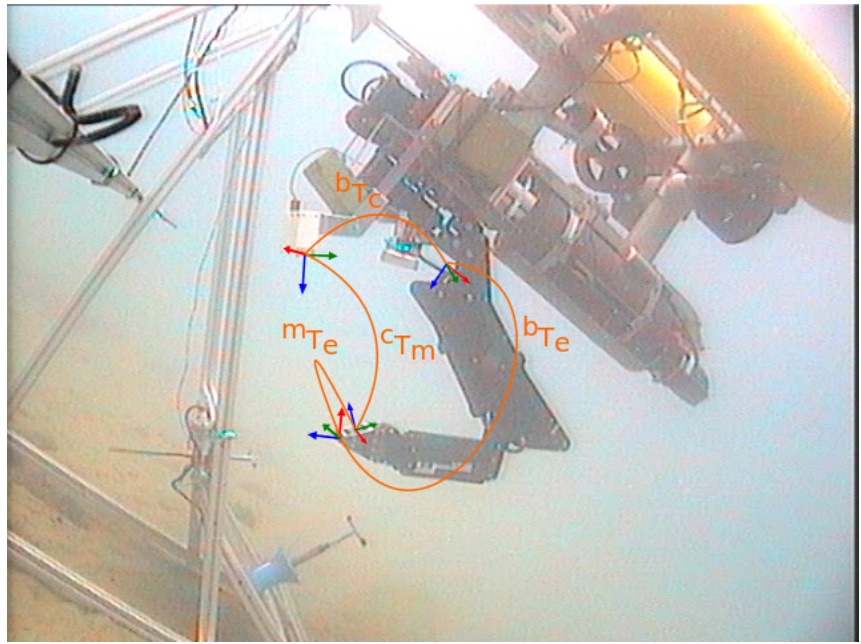
Figure 6. Girona 500 I-AUV at sea performing a fixed-base manipulation with all the manipulation system frames and transformations